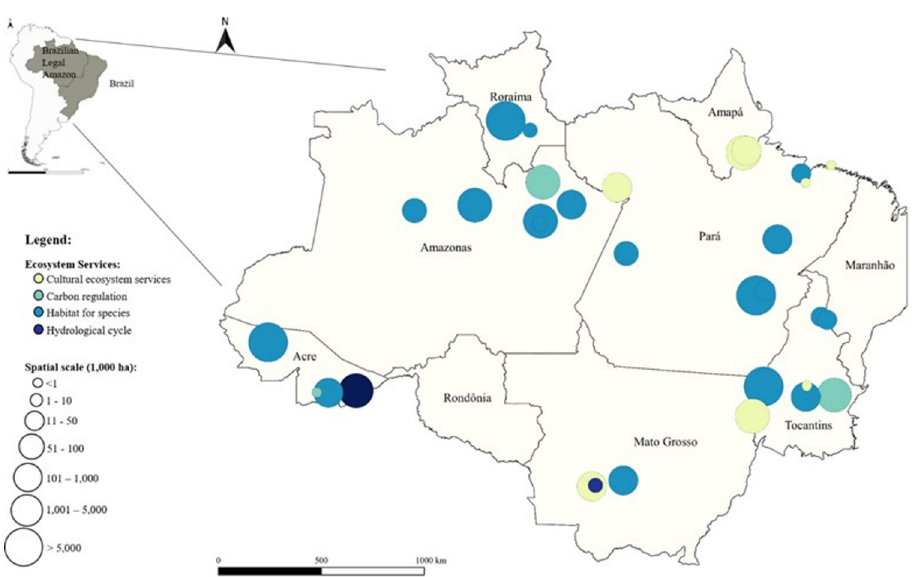
Fig 2. Spatial distribution of Brazilian valuation studies included in the database and their scope and scale of analysis. Note: the map excludes the valuation studies that aimed to value the whole Brazilian Amazon. Sources: The maps underlying Fig 2 are based on open access files obtained from the Brazilian Institute of Geography and Statistics (Instituto Brasileiro de Geografia e Estatı´stica–IBGE).